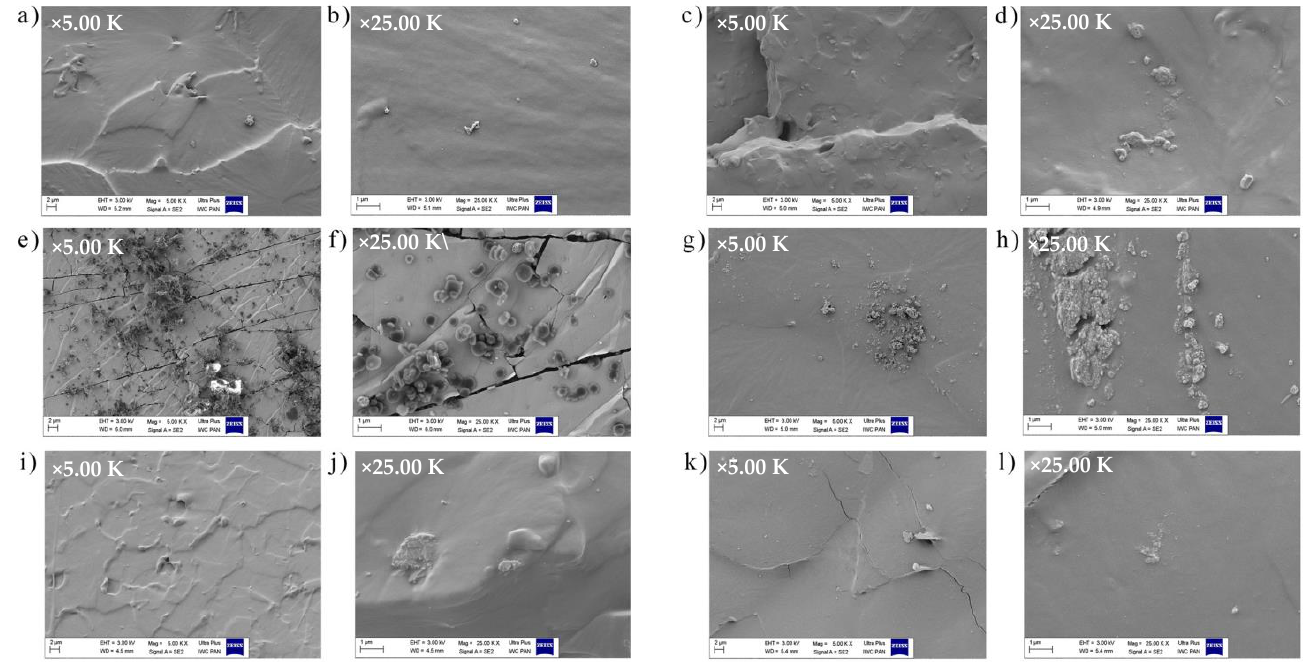
Figure 6. SEM images obtained for the following materials: ( a , b ) pure ethylene-propylene rubber (EPM), ( c , d ) EPM-quercetin, ( e , f ) EPM-S.Y. 163, ( g , h ) EPM-S.R. 207, ( i , j ) EPM-quercetin-S.Y. 163, ( k , l ) EPM-quercetin-S.R. 207 at a 5000 and 25,000× magnification, respectively.